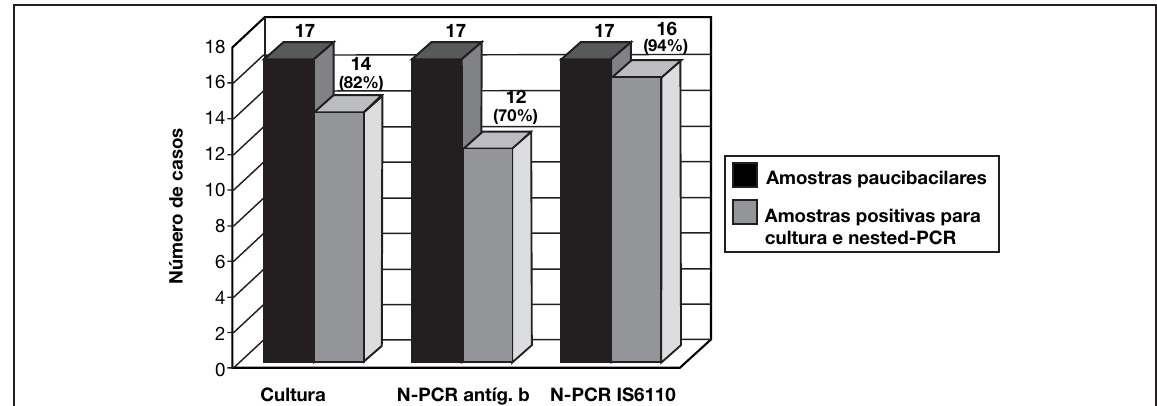
Figura – Percentuais de positividade dos métodos de diagnóstico (cultura e nested-PCR) nos casos de tuberculose